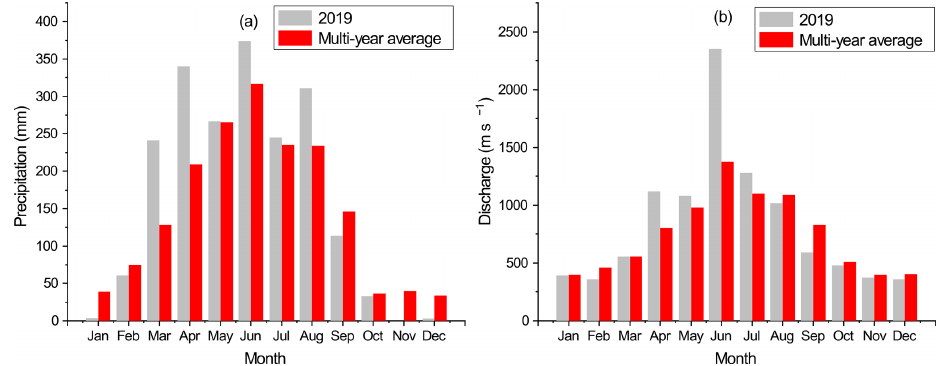
Figure 2. Monthly variations in (a) precipitation of the DJRB and (b) water discharge at the Boluo hydrological gauge, based on data provided by the Hydrological Bureau of Guangdong